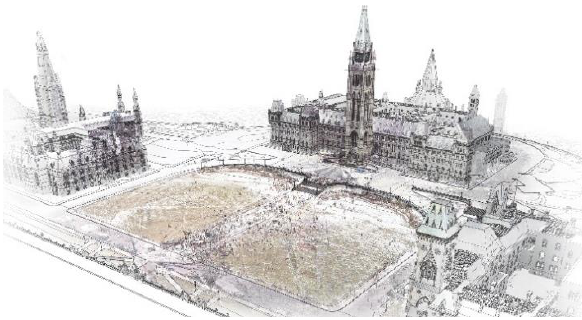
Figure 1. BIM Parliament Hill with point cloud overlaid.